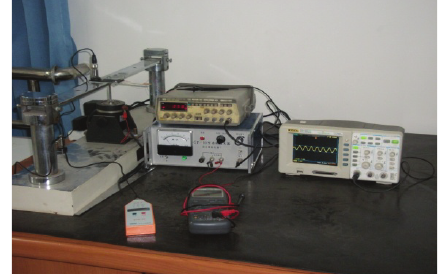
Figure 9: Experimental platform of piezoelectric generator.